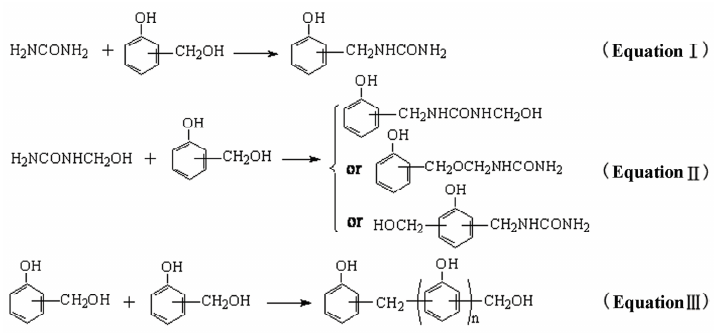
Figure 1. The condensation reactions during the synthesis of PUF resin.